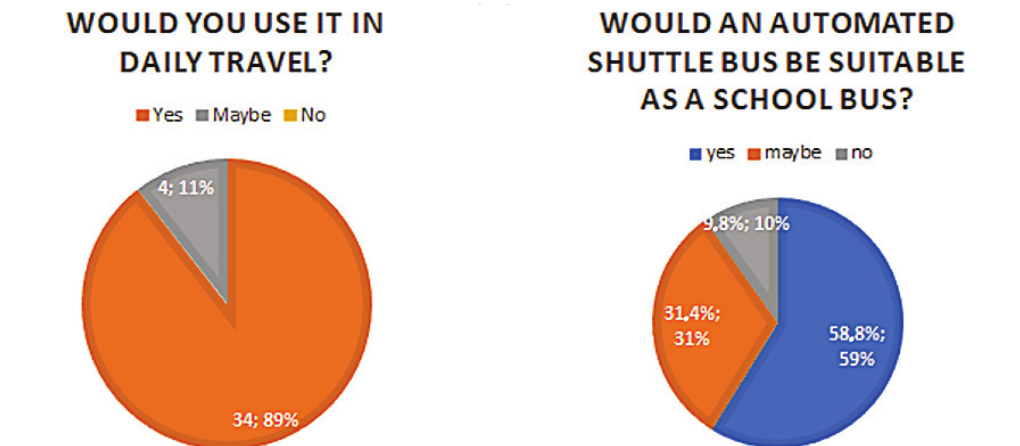
Fig. 4 . Two charts on passengers ʼ safety perception.